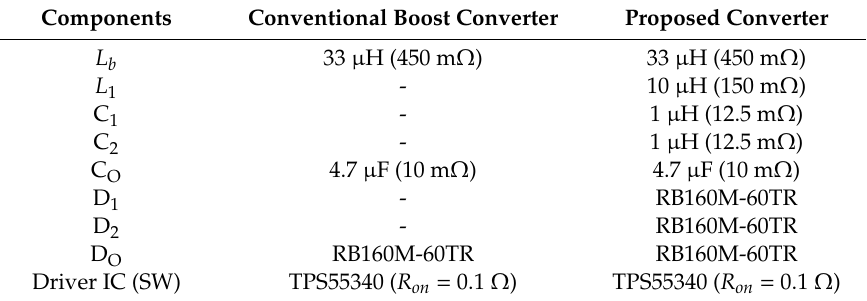
Table 1. Component values for the experimental boost converters.